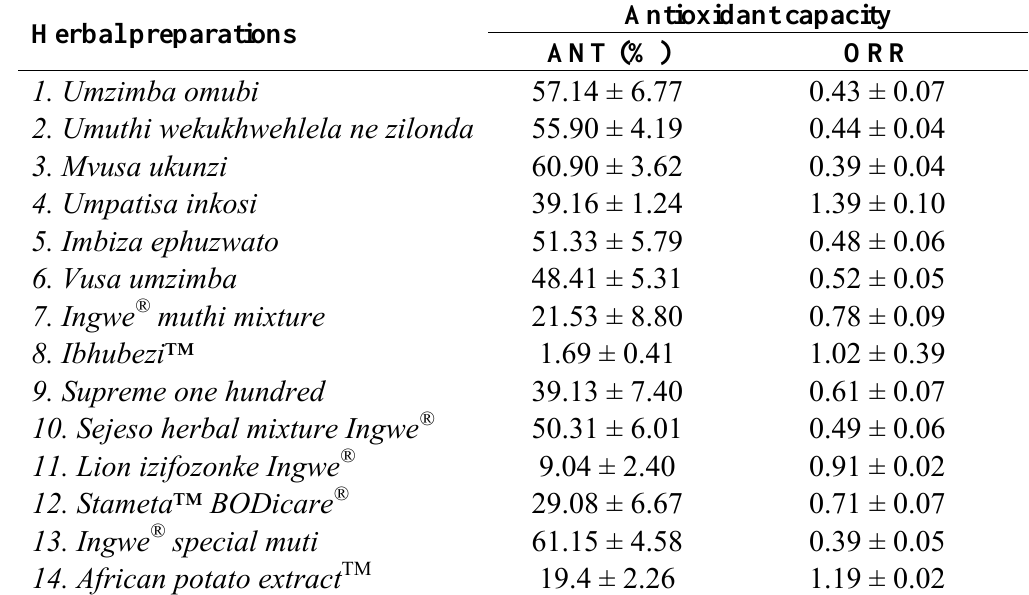
Table 2. Antioxidant activity as determined by the β -carotene-linoleic acid model system of the fourteen herbal preparations sold in Pietermaritzburg,